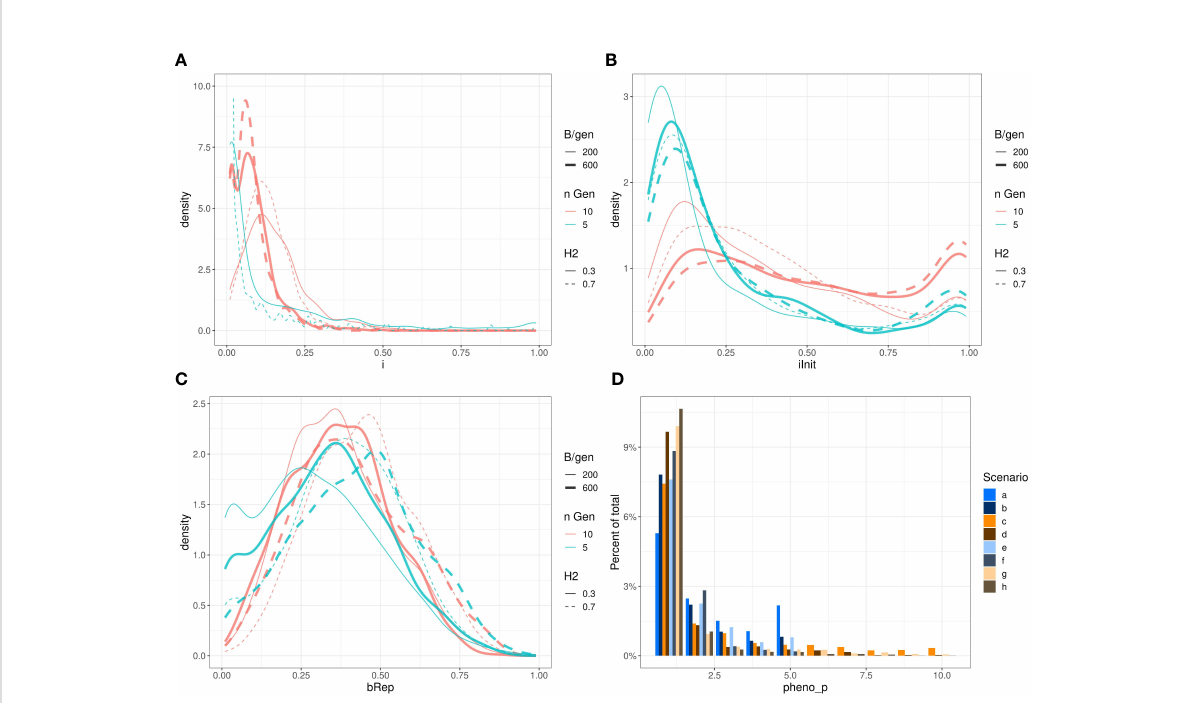
FIGURE 7 Marginal distributions of the optimised parameters i (A) ; i Init (B) ; B rep (C) and pheno p (D) returned by Bayesian optimisation. To keep the sub fi gure (A) readable, we have removed the scenarios b. and f. ( n gen = 5 and B = n gen × 600). Those densities stick on the left side of the graph and raised to very high values: respectively ~150 and ~800. Also, we restricted the vertical axis from 0 to 10 therefore, the top of the curve for scenario e. ( H 2 =0.7, n gen =5, B =5×200 ) reaching ~50 is out of